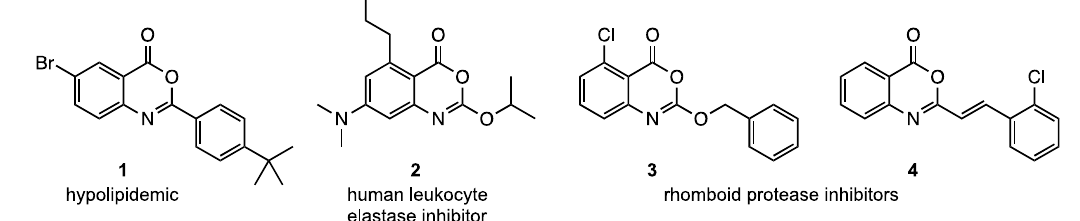
Figure 1. 4 H -Benzo[ d ][1,3]oxazin-4-ones with potential drug